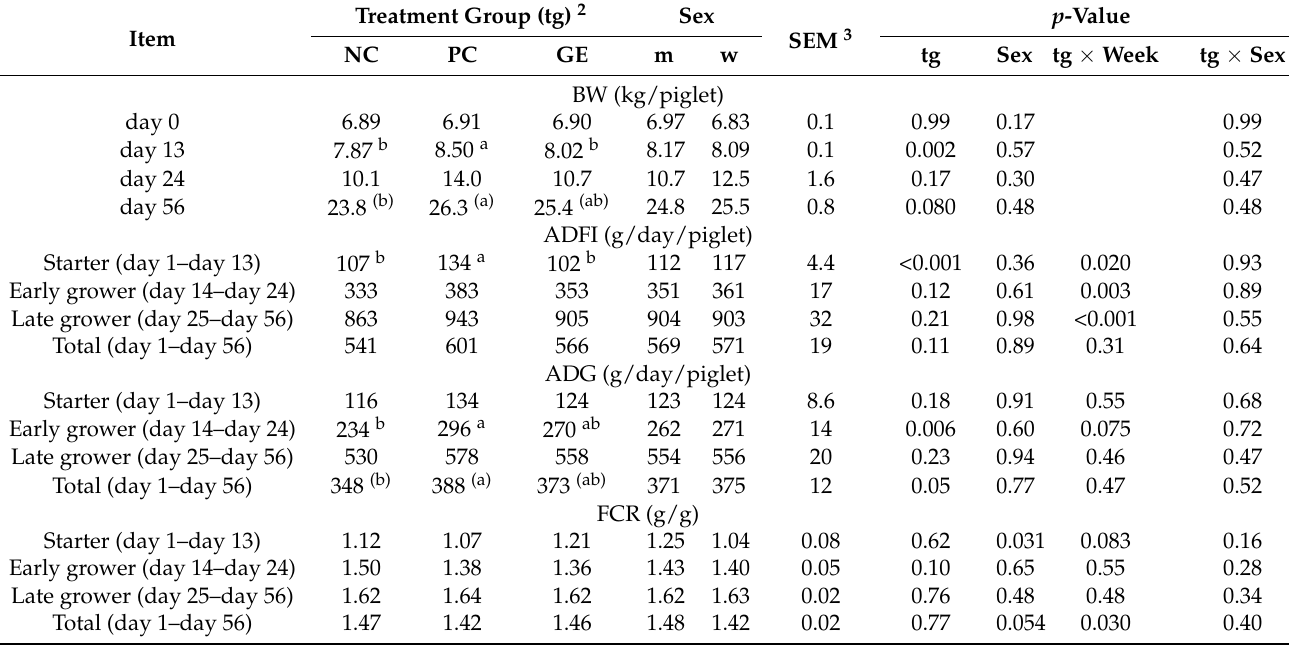
Table 3. Effect of using NC and PC for testing dietary GE supplementation on average daily feed intake (ADFI), average daily gain (ADG) and feed conversion rate (FCR) of weaning piglets 1